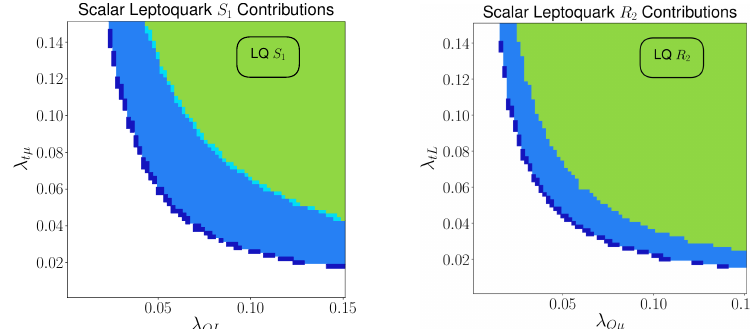
and ∆ a BNL in the planes of the leptoquark couplings where we profile Figure 4. Results for ∆ a 2021 µ µ over all possible scalar leptoquark masses up to 4 . 5 TeV. More specifically in the left panel we show results for the SU(2) singlet S defined in eq. (3.4) in the λ – λ plane and in the right panel we L 1 QL tµ show the scalar leptoquark SU(2) doublet R defined in eq. (3.5) in the λ – λ plane. We show L 2 Qµ tL couplings between the leptoquark and the SM fermions that can satisfy direct LHC searches and (green) or both ∆ a BNL Z → µµ and Z → νν constraints and can simulteneously explain ∆ a 2021 and µ µ ∆ a 2021 (lime green) within 1 σ . Additionally points which can also avoid the fine-tuning constraints µ in eq. (3.8) on the muon mass are shaded in dark blue if they can explain ∆ a 2021 , aqua if they can µ explain ∆ a BNL within 1 σ , and blue if they can explain both µ